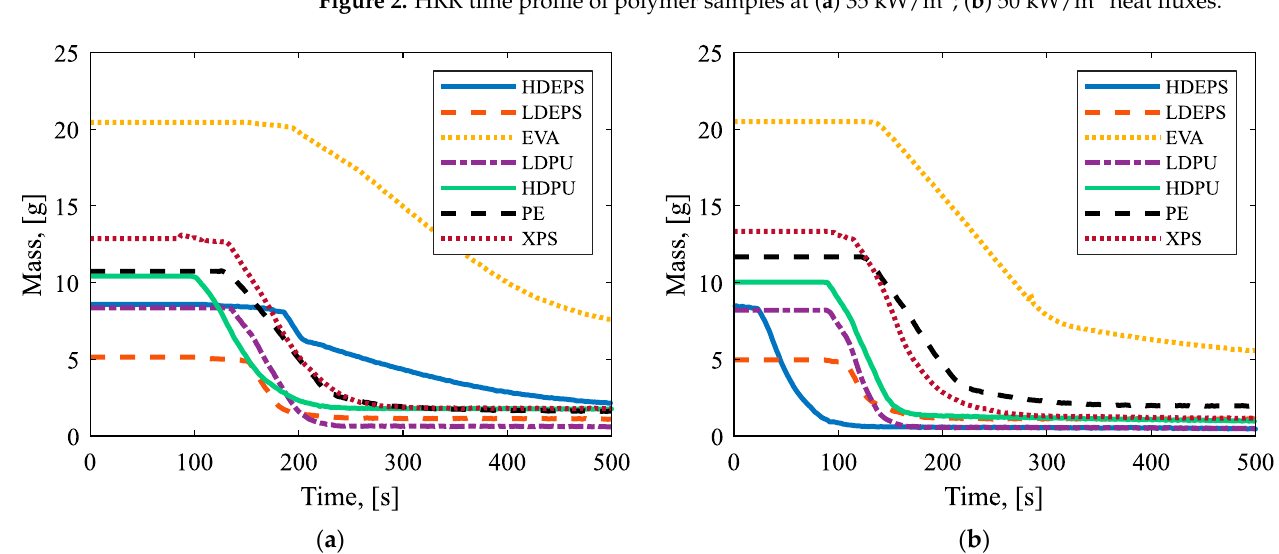
Figure 3. Mass loss time profile of polymer samples at ( a ) 35 kW/m 2 ; ( b ) 50 kW/m 2 heat fluxes.